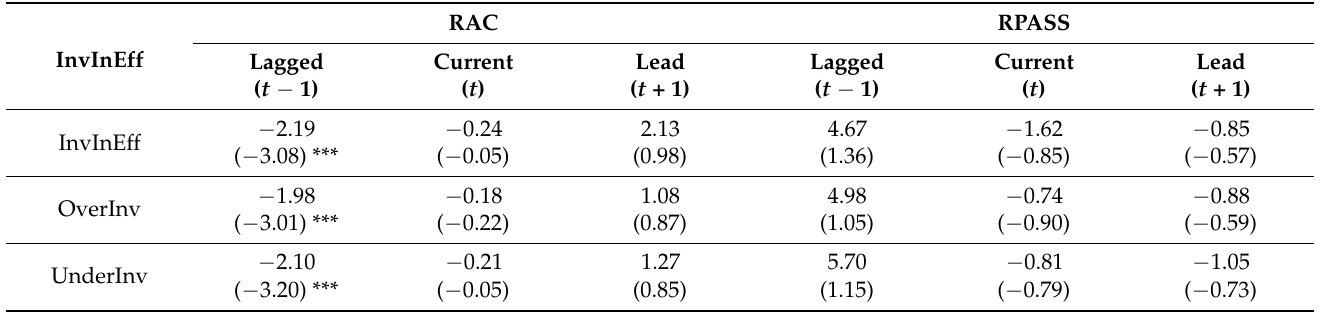
Table 8. Causality tests of institutional ownership